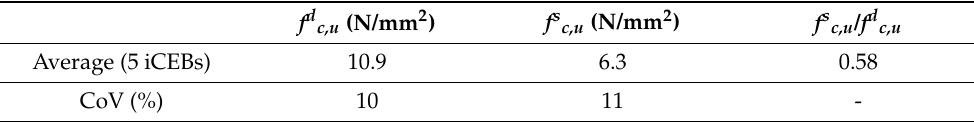
Table 4. Results of the compression tests of the